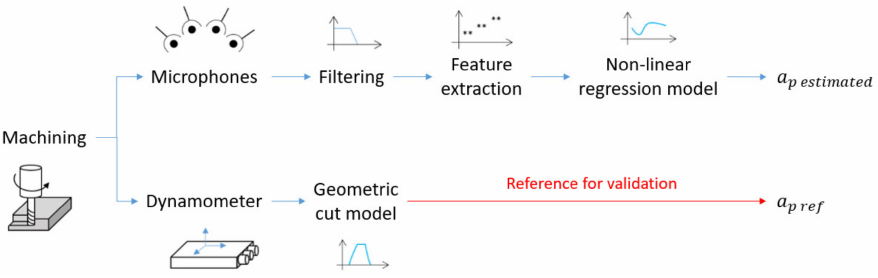
(cid:0) (cid:1) a p